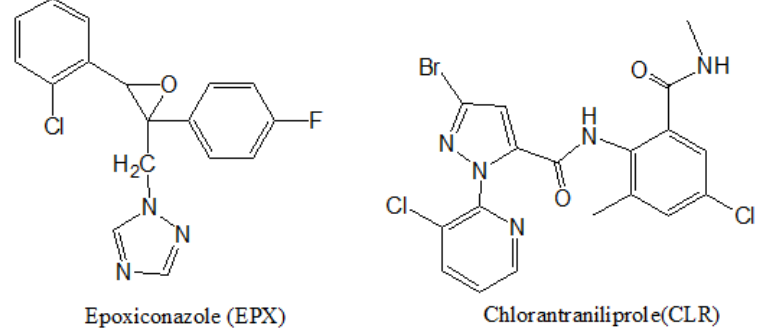
Figure 1. Chemical structures of epoxiconazole (EPX) and chlorantraniliprole